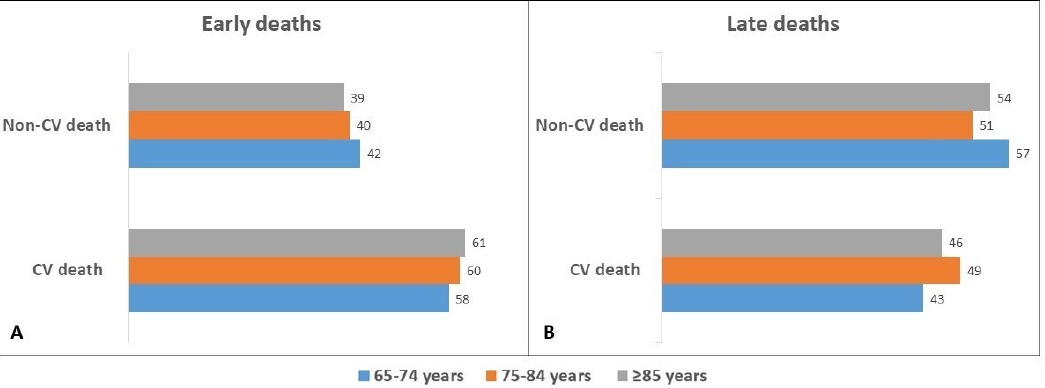
Figure 1. Comparison of Early ( A ) vs. Late ( B ) mortality rates according to causes of death among the different age groups. Table 4. Predictors of in-hospital mortality by age groups (Univariate Table 3. In-hospital length of stay and mortality.